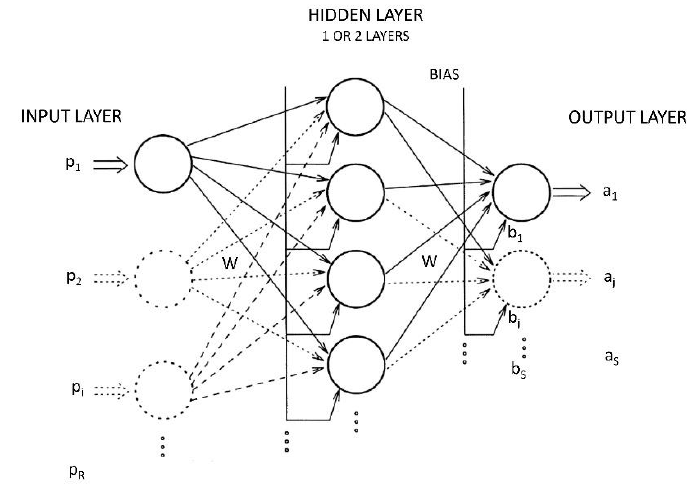
Figure 2. Multilayer perceptron frame with one hidden layer.